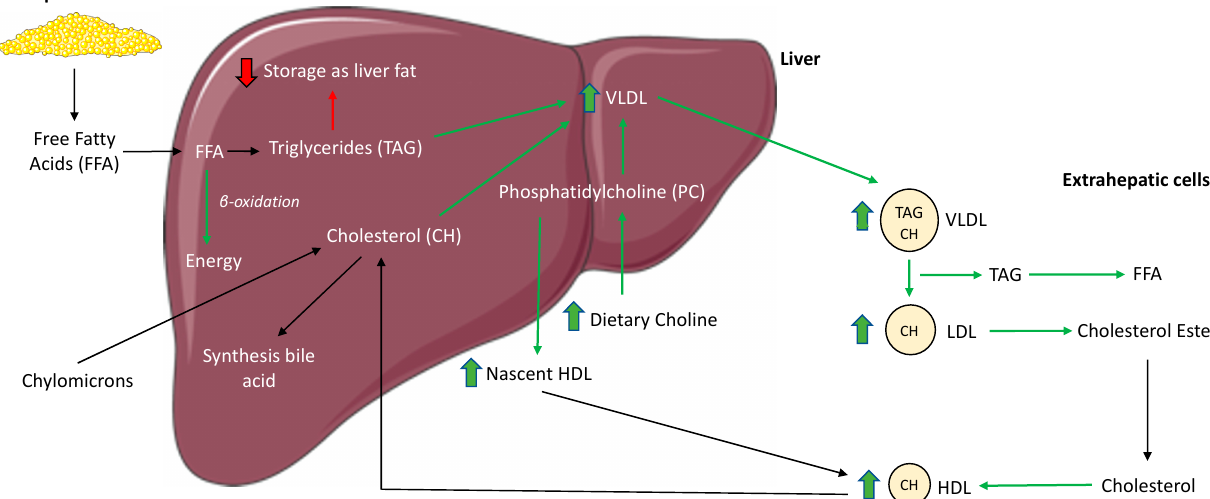
Figure 2. The proposed mechanism by which supplemental dietary choline alters the hepatic lipid and lipoprotein metabolism in obese cats. An increase in dietary choline allows for an increase in phosphatidylcholine (PC), necessary for the formation of very-low-density lipoproteins (VLDL). Hepatic triacylglycerides (TAG) and cholesterol are packed into VLDL and put into circulation for distribution within the body. The formation of nascent high-density lipoprotein (HDL) within the liver is also dependent on PC. PC: phosphatidylcholine; VLDL: very-low-density lipoprotein; HDL: high-density lipoprotein; LDL: low-density lipoprotein; TAG: triacylglycerides; FFA: free fatty acids.